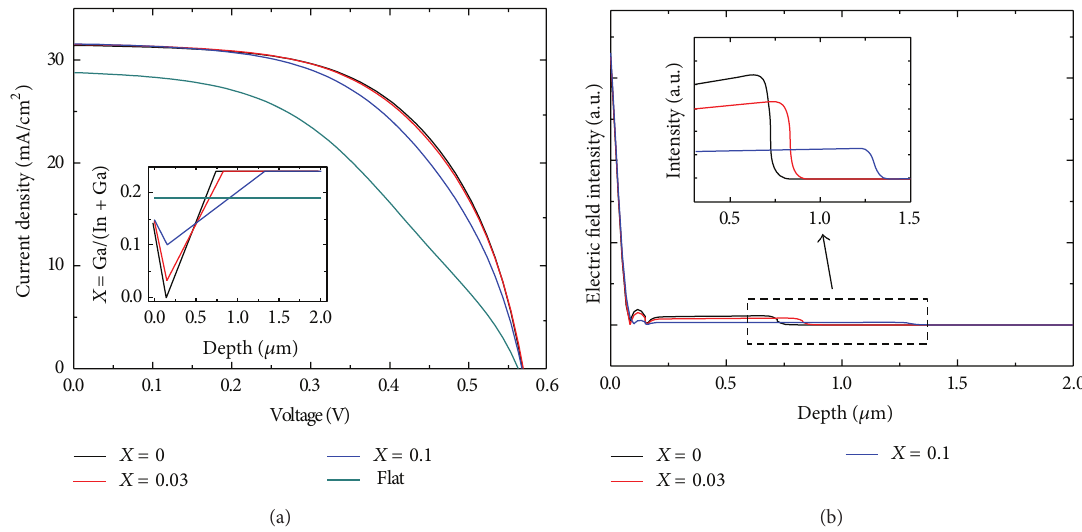
Figure 2: (a) Current density-voltage curves and (b) electric filed intensity of CIGS cells with different bandgap grading profiles taken under illumination with an intensity of 1 sun at room temperature (300 K).